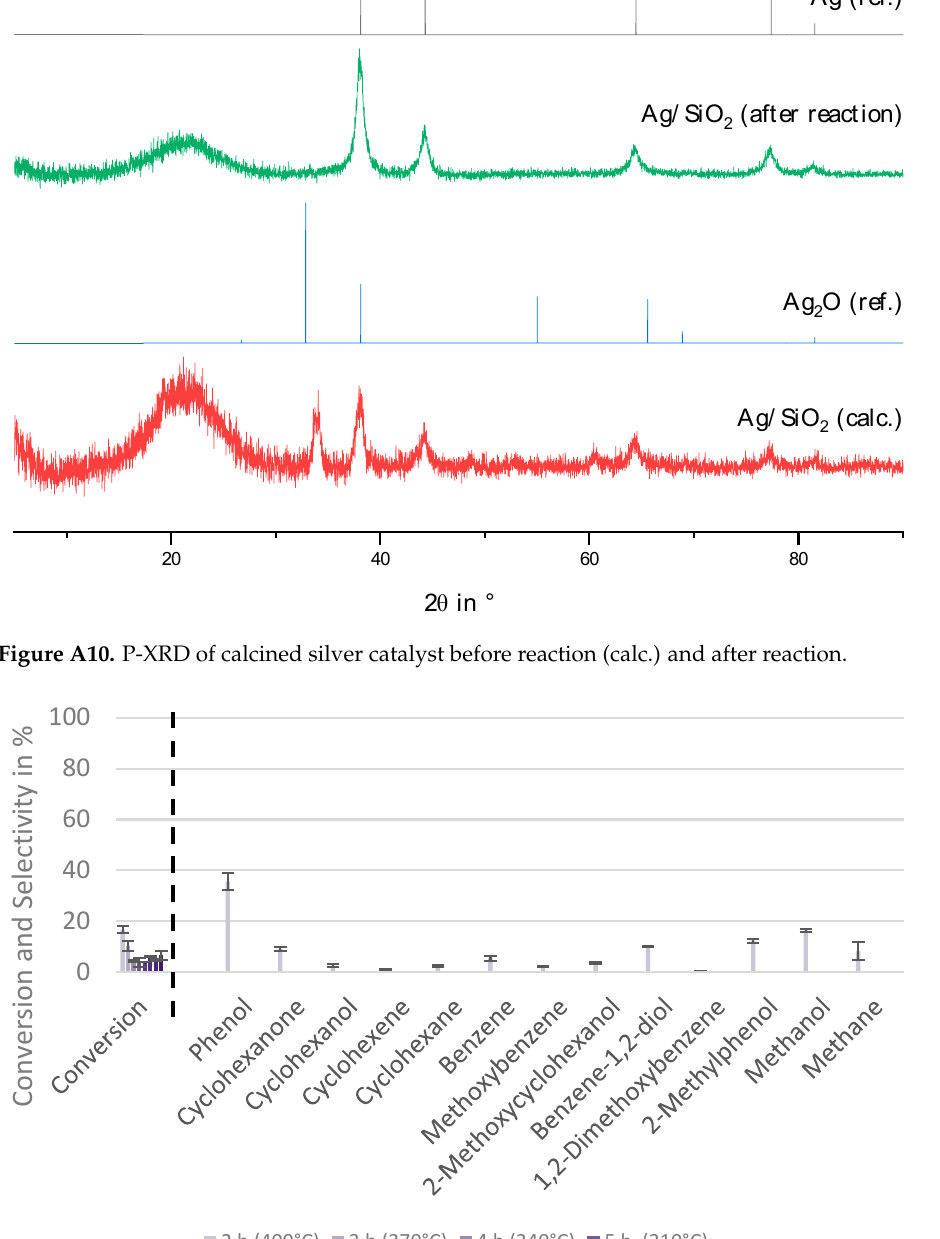
Figure A11. Conversion and selectivities of the test measurement with reversed temperature profile of the palladium-silica catalyst material. Selectivities for conversions < 15% (Tos 3h to 9h) are not shown for accuracy. Coke fraction = 10.64 ± 0.02%.